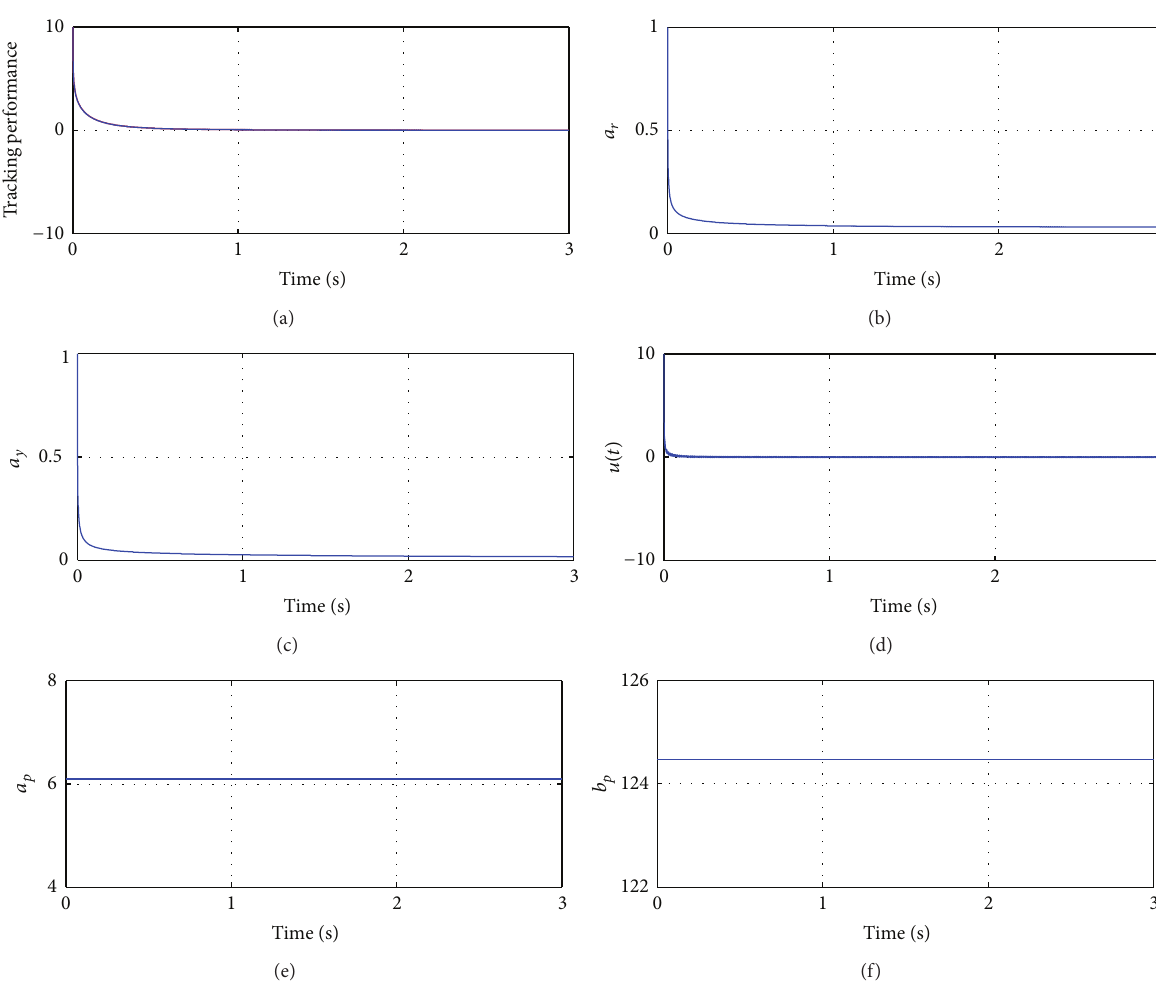
Figure1:Fractionaladaptivecontrolofthefractionallinearsystem(6).(a)Trackingperformance(redlinerepresentsthestateofthefractional plant, while the blue line represents the state of the fractional reference model); (b) control parameter ̂𝑎 𝑟 (𝑡) ; (c) control parameter ̂𝑎 𝑦 (𝑡) ; (d) control input 𝑢(𝑡) ; (e) estimation of parameter 𝑎 𝑝 (𝑡) ; (f) estimation of parameter 𝑎 𝑦 (𝑡) .